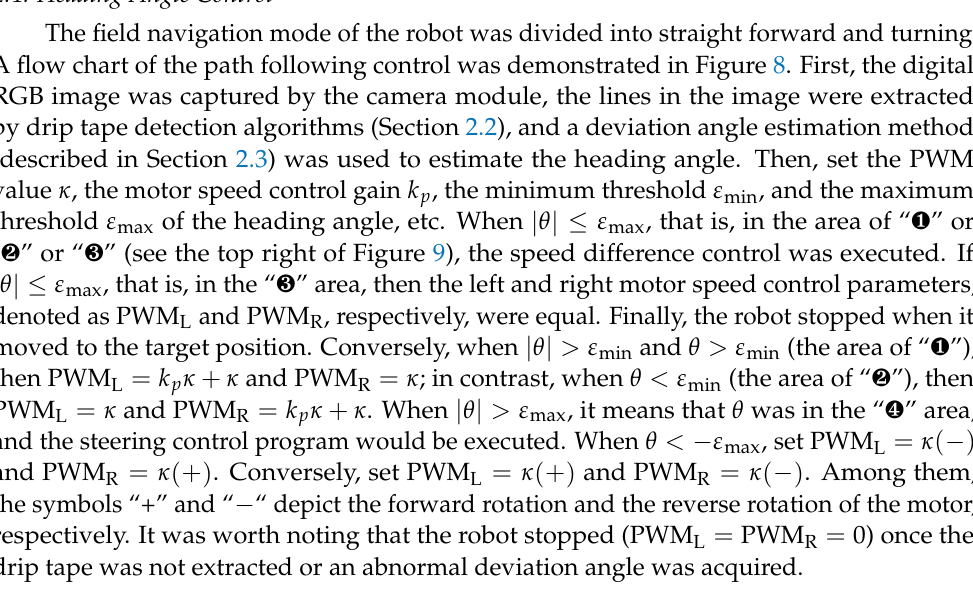
Figure 8. The deviation of heading angle estimation (red line: desired line; blue line: vertical line in the center of the image; white dotted line: horizontal line in the center of the image).